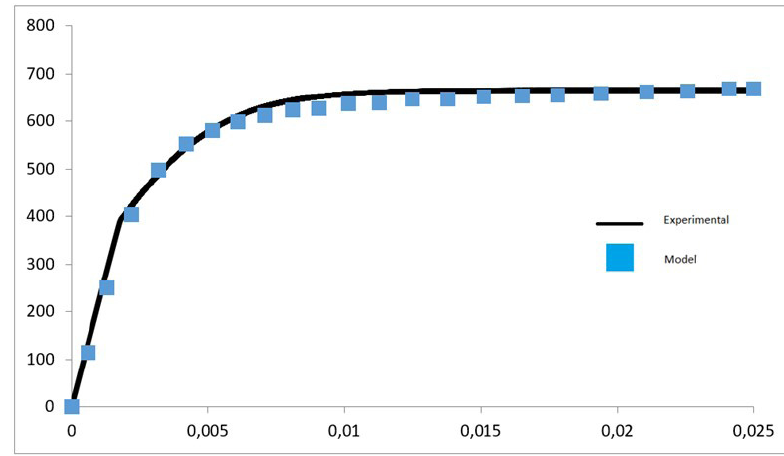
Figure 9. Comparative stress curve (MPa) - strain (mm / mm) -